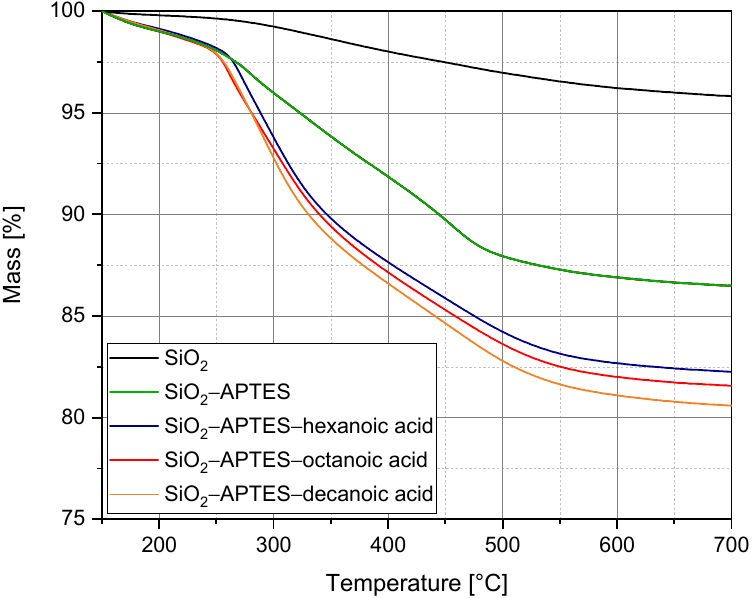
Figure 5. Thermogravimetric analysis of unmodified silica nanoparticles (SiO 2 ) as a reference and silica nanoparticles after modification with APTES (SiO 2 –APTES) as well as after two-step modification with APTES and different carboxylic acids (SiO 2 –APTES–hexanoic acid, SiO 2 –APTES–octanoic acid, and SiO 2 –APTES–decanoic acid).